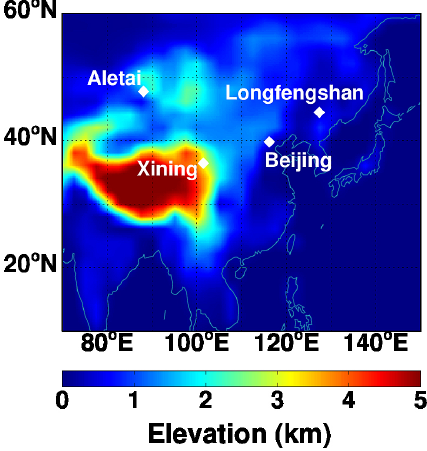
Figure 1. Locations of Beijing (39.8 ◦ N, 116.18 ◦ E) and three other ozonesonde stations in north China during the second phase of the TAPTO-China campaign in April–May 2005. Colors denote surface